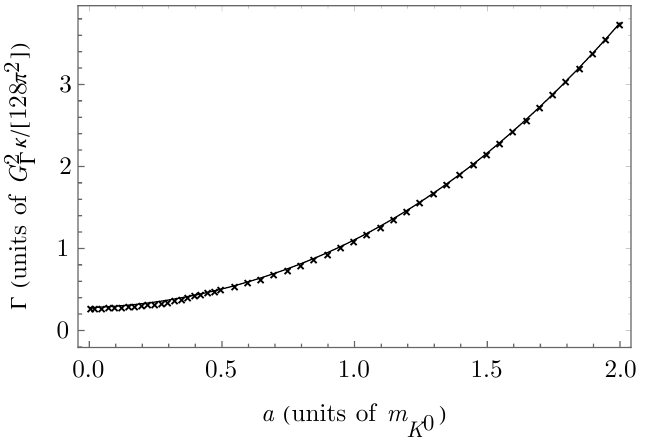
Figure 2 . Numerical results for the decay rate Γ as a function of the acceleration a and fitted curve. effect would only be detectable at extremely high energies, given that the acceleration is displayed in units of the kaon mass, which corresponds to accelerations of over 10 32 m / s 2